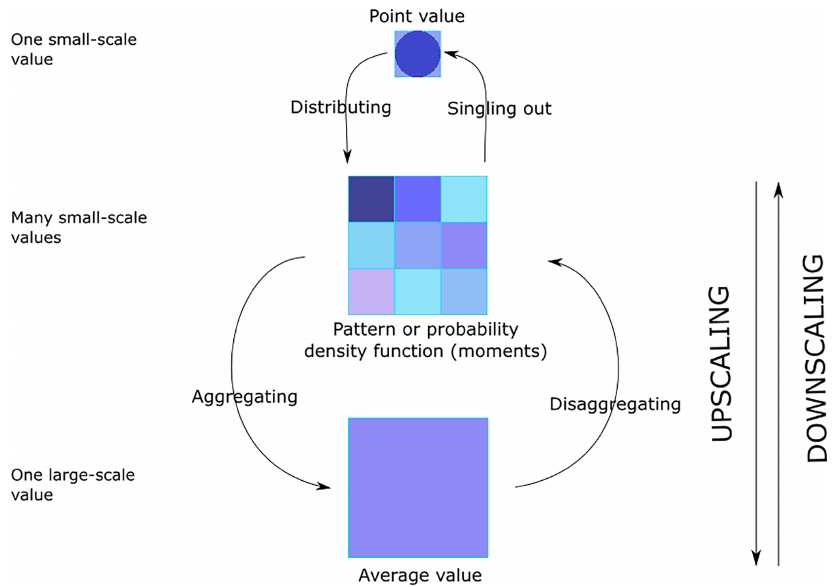
Figure 2. Downscaling and upscaling processes (modified from Blöschl and Sivapalan, 1995).